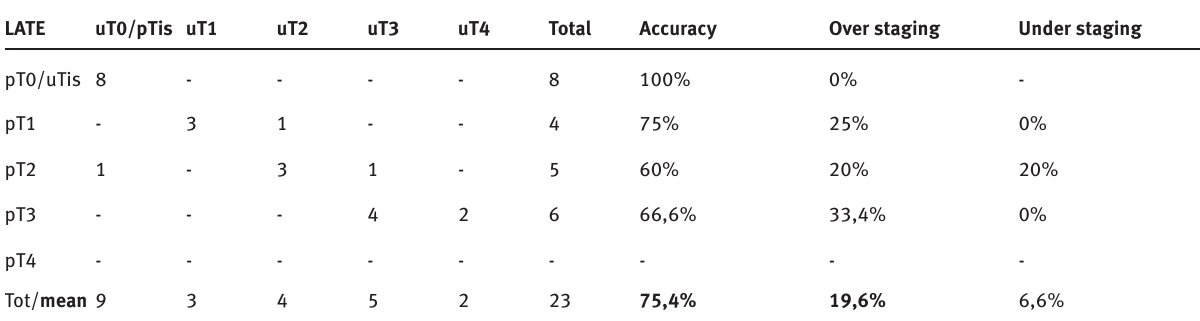
Table 2 : Accuracy, overstaging and substaging risk for T stages – Late group